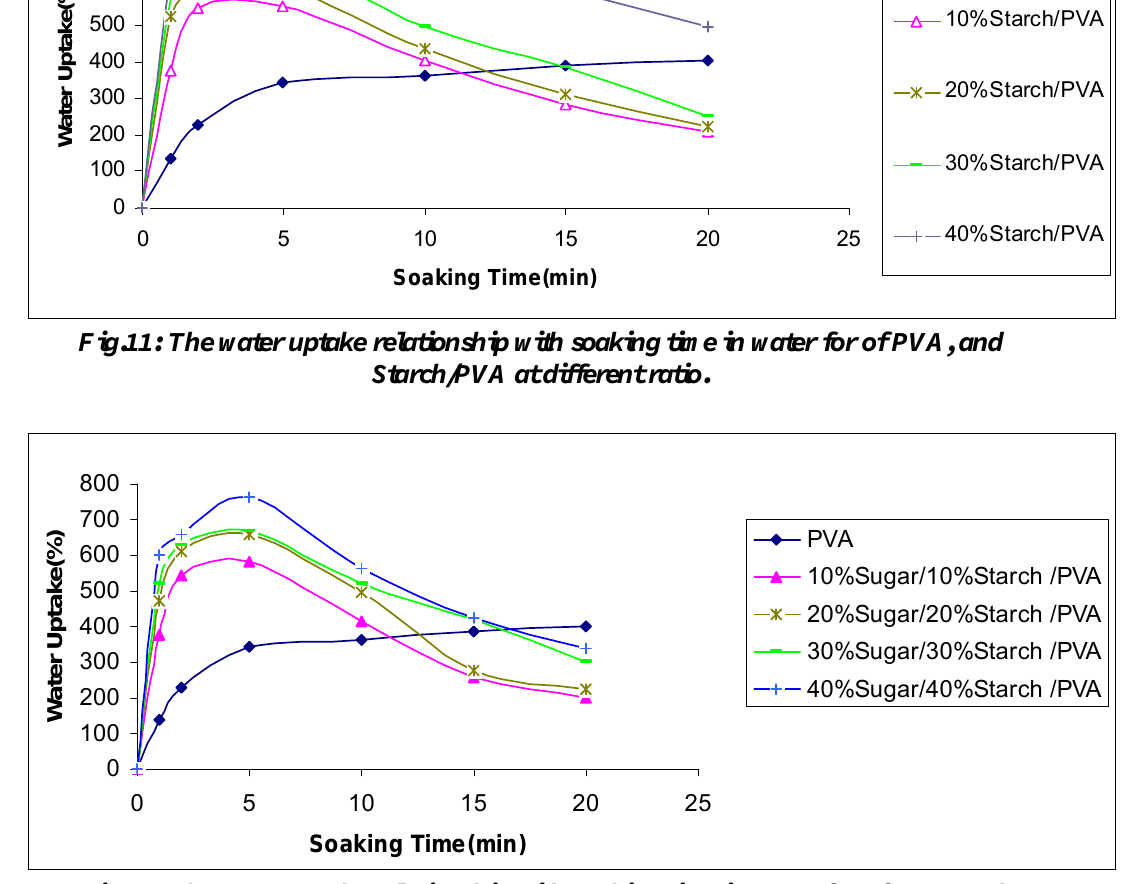
Fig.12: The water uptake relationship with soaking time in water for of PVA, and Starch/PVA/sugar at different